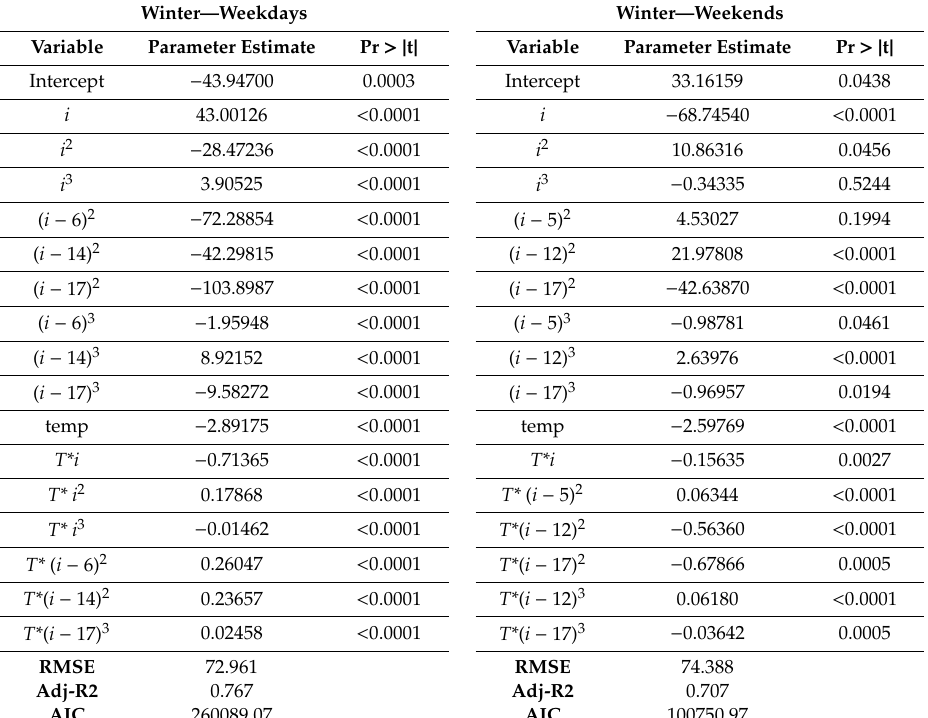
Table A2. The Results for the Regression Model for the Winter Season (Model 1).